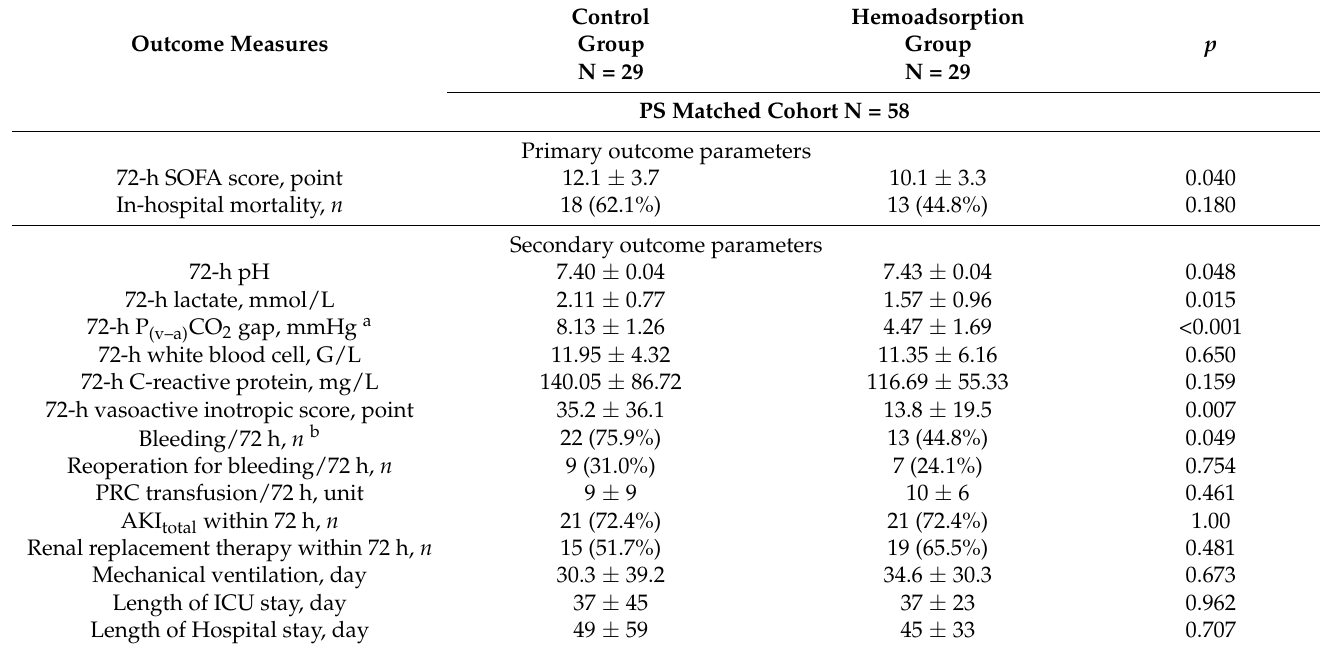
Figure 2. Within-subjects change in sequential organ failure assessment score over the first 72 h of venoarterial extracorporeal membrane oxygenation support. N = 58. Data are presented as means. Error bars show 95% confidence intervals. SOFA: sequential organ failure assessment; VA–ECMO: venoarterial extracorporeal membrane oxygenation. Table 2. Comparative analysis of the primary and secondary outcome parameters in the propensity score matched cohort.